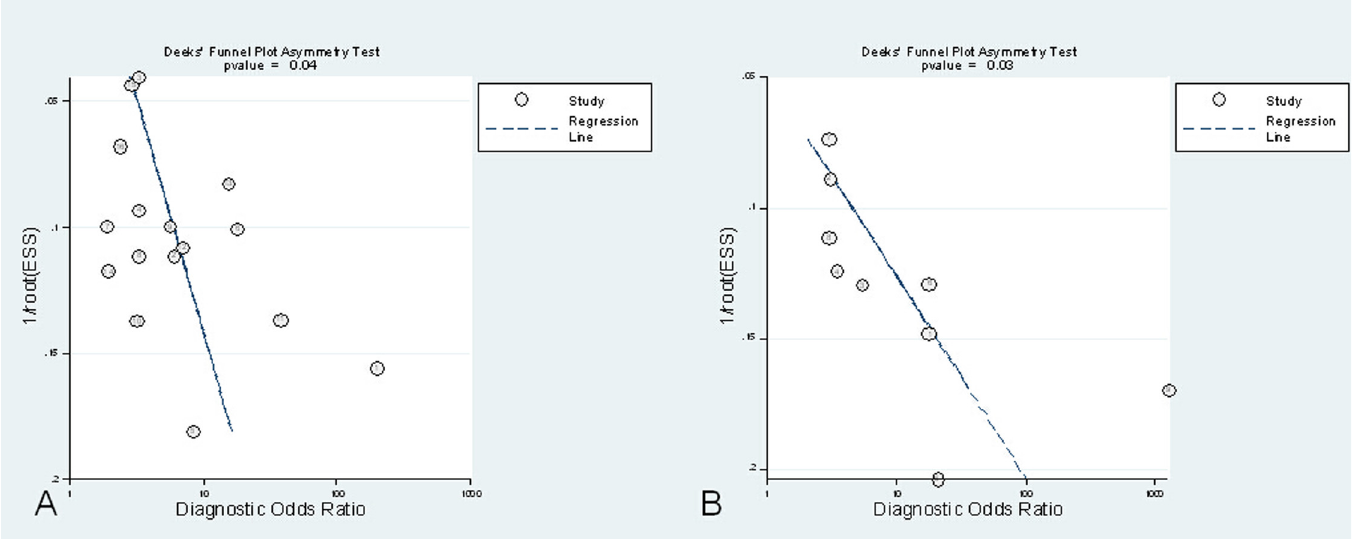
Fig 2. Deek ’ s funnel plot asymmetry test for publication bias (A. For single procalcitonin concentration; B. For procalcitonin non-clearance). Potential publication bias exists (P <